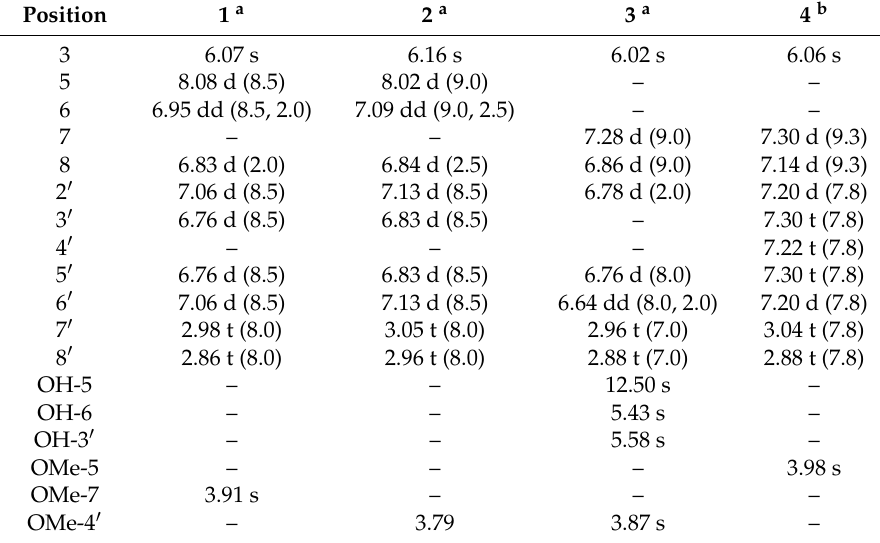
Table 2. 1 H-NMR data for compounds 1 – 4 ( δ in ppm, J in Hz).